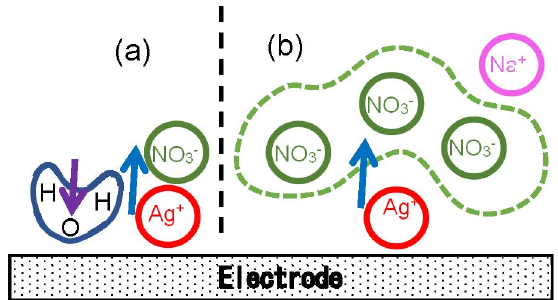
Figure 6. Illustration of the arrangement of NO 3 − ions near a newborn Ag + at ( a ) high and ( b ) low concentrations. A H 2 O dipole in ( a ) is oriented in the direction opposite to that of AgNO 3 to cause the double-layer capacitance.